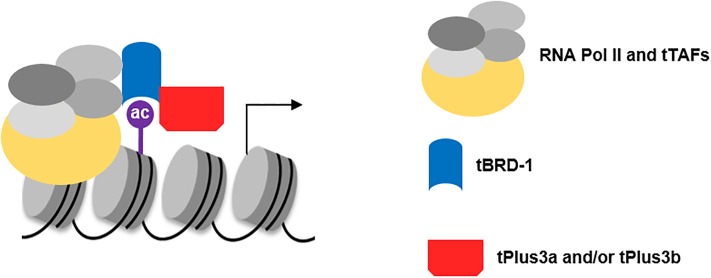
Model of the complex formation of tPlus3a and tPlus3b, tBRD-1, and other factors in gene activation.tPlus3a and tPlus3b molecularly interact with tBRD-1, which binds to acetylated histones. tBRD-1 interacts with the tTAF Sa to activate RNA Polymerase mediated transcription.